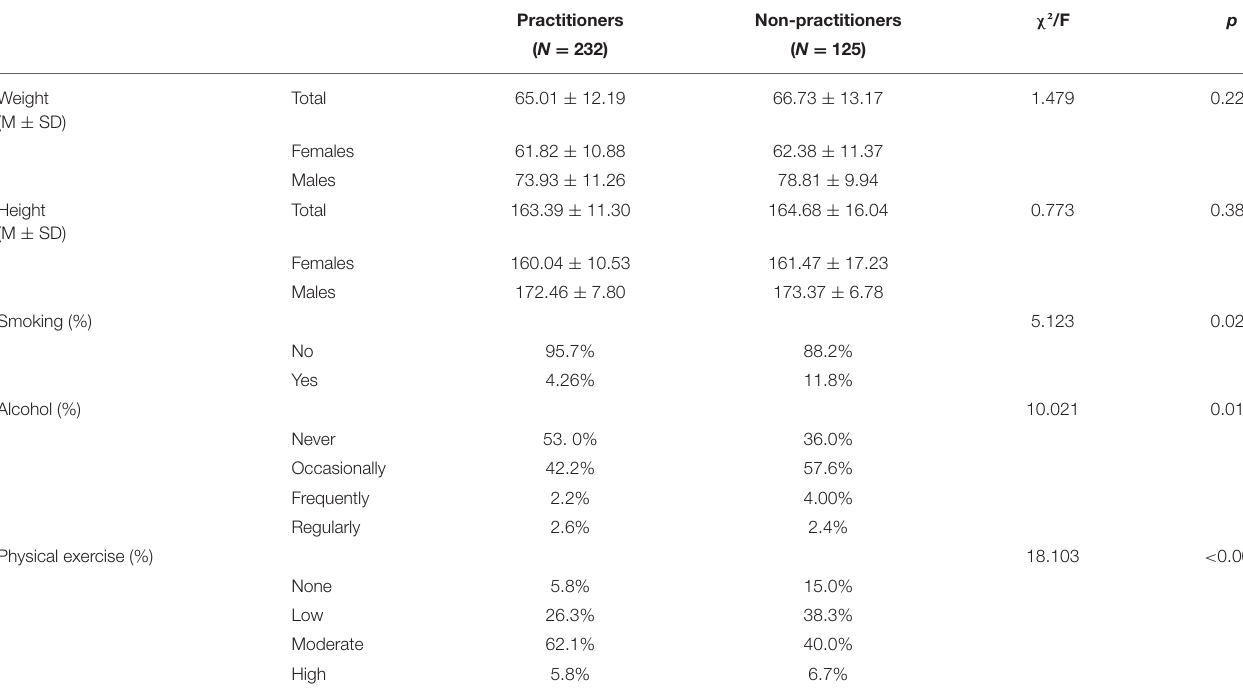
TABLE 1B | Descriptive statistics and differences between yoga practitioners and non-practitioners in weight, height, and life